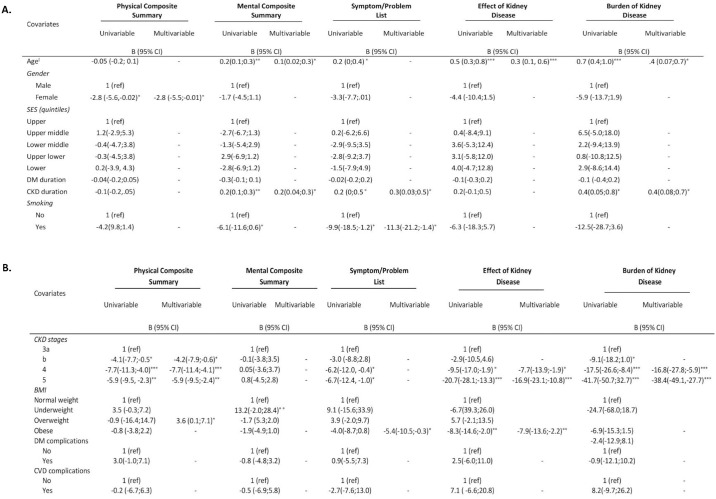
Summary of factors predicting health-related quality of life in patients with diabetes and chronic kidney disease.ĭThe regression coefficient is for a one year increase in age; * p<0.05; **p<0.01; ***p<0.001; SES-Socio Economic Status; DM-Diabetes Mellitus; CKD-Chronic Kidney Disease; CVD-Cardiovascular Disease; BMI-Body Mass Index.